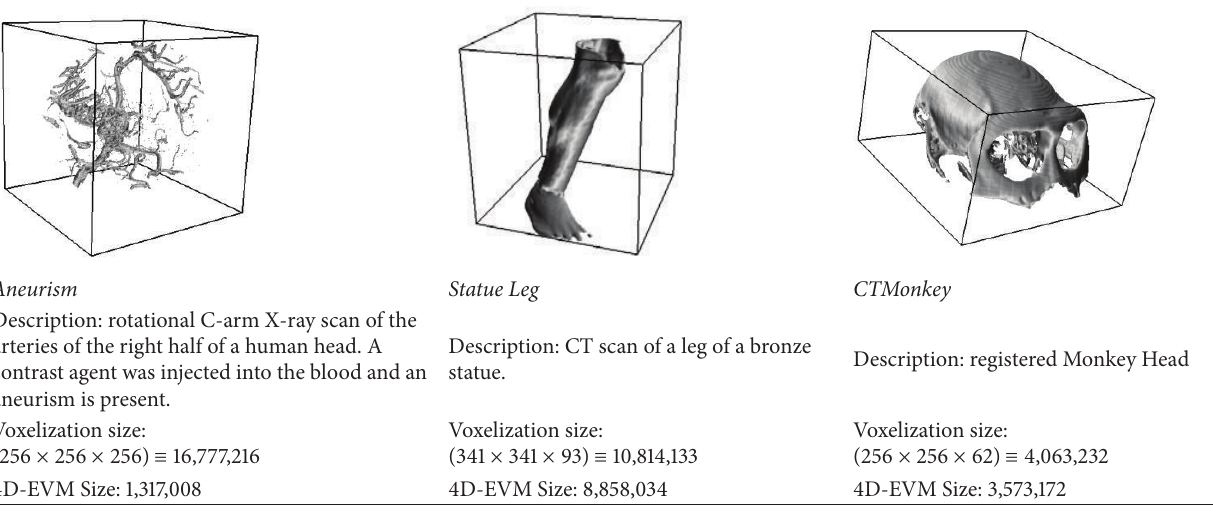
Aneurism Statue Leg CTMonkey